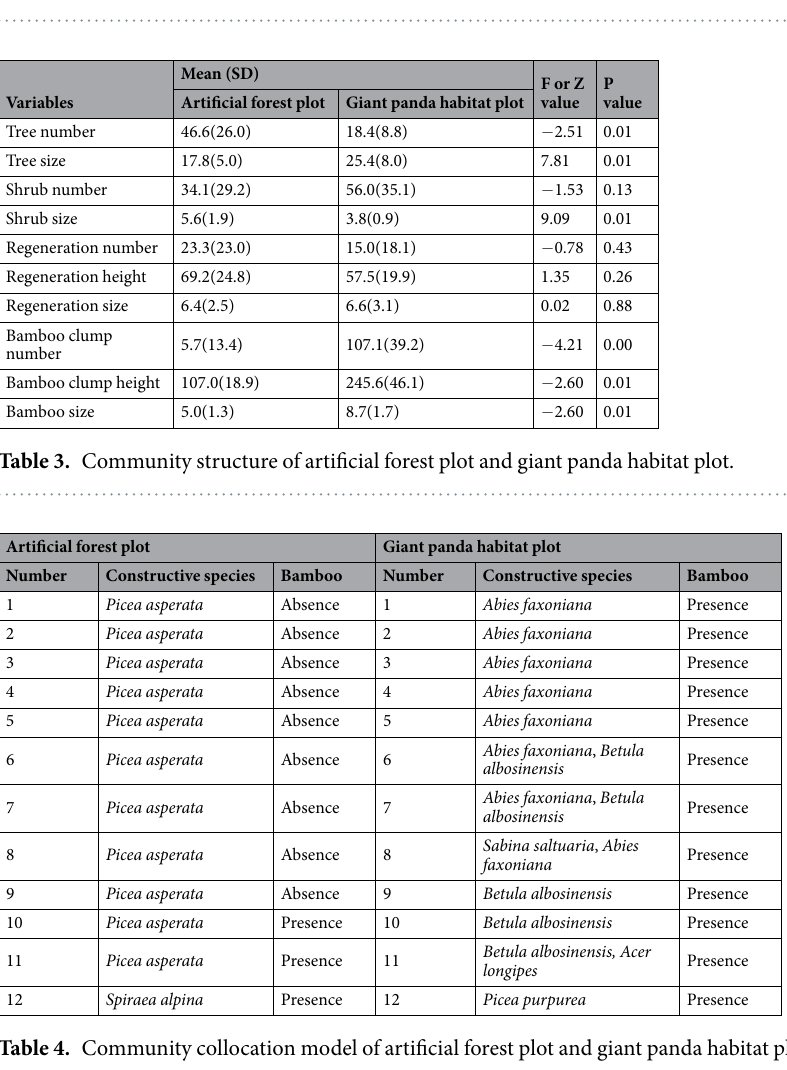
Table 2. Species richness and diversity index of artificial forest plot and giant panda habitat plot.